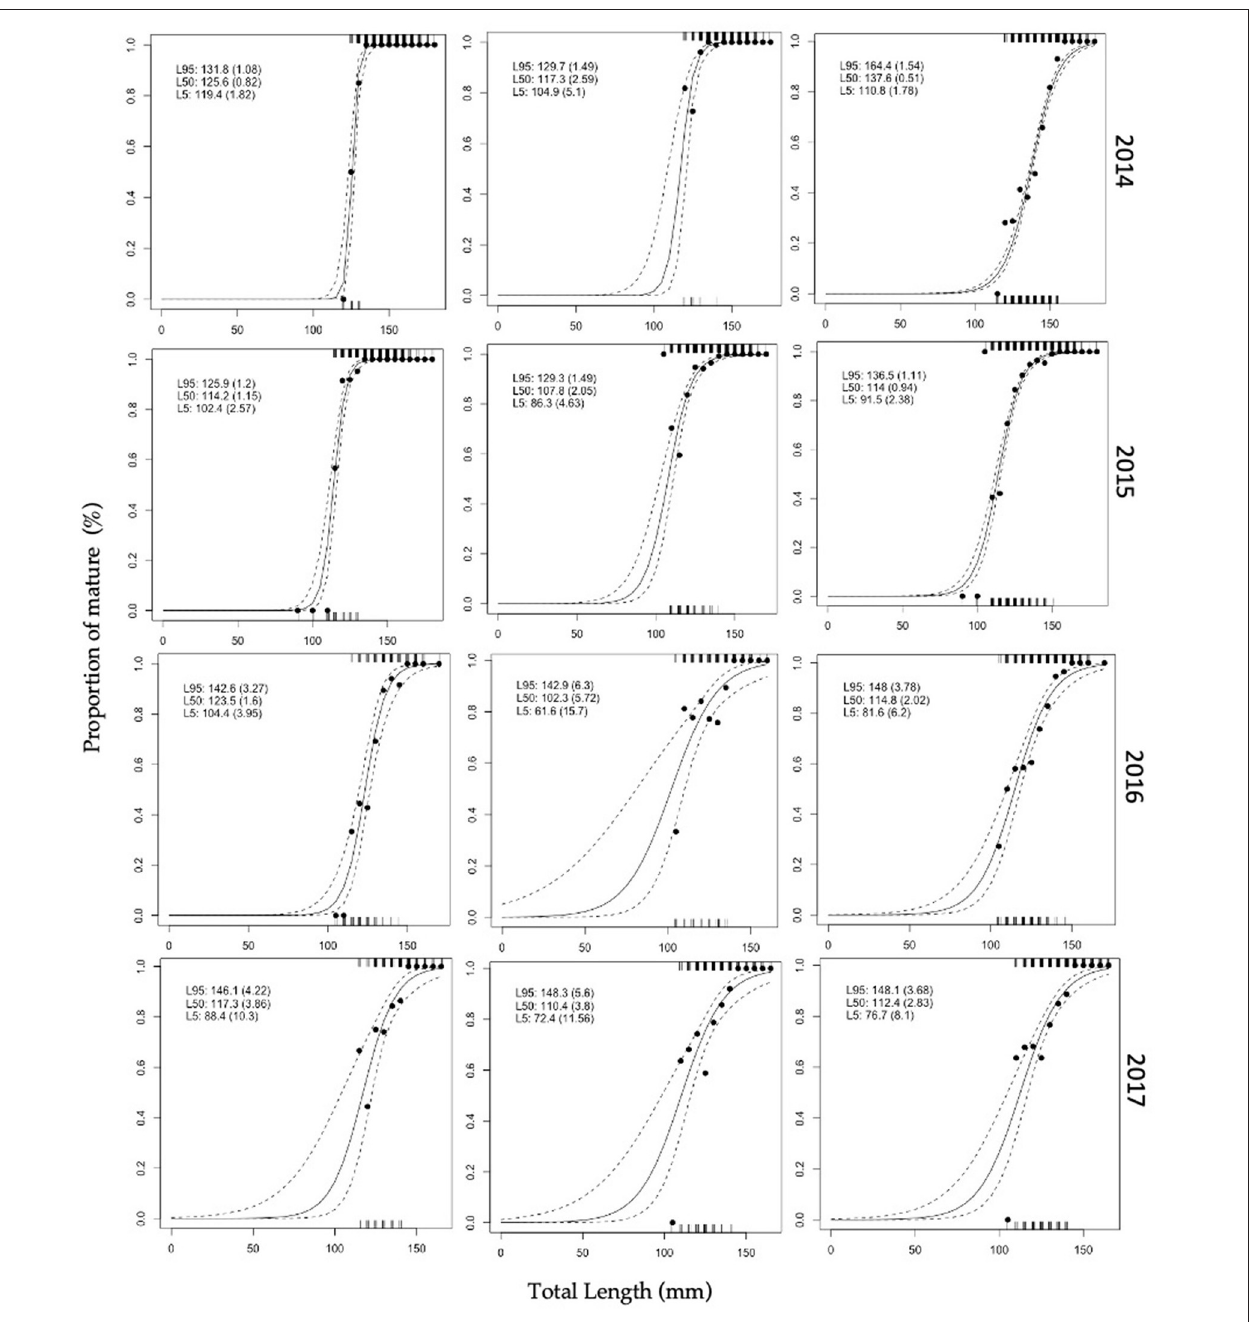
FIGURE 5 | Maturity ogives for European sardine in the Strait of Sicily per year, from 2009 to 2017 for females (left panels) males (middle panels) and overall (right panels). Solid line is the predicted proportions of mature ES at length, the dashed lines denote the 95% confidence curves, and the tick marks on the bottom and top axes indicate the immature and mature ES recorded, respectively. The proportion of mature for each bin are also reported (black, filled circles). The point estimates for mean size ( + 95% CL) are also provided for 5% (L 5 ), 50% (L 50 ), and 95% (L 95 ) mature individuals. See Table 2 for more details about the logistic equation parameters for each